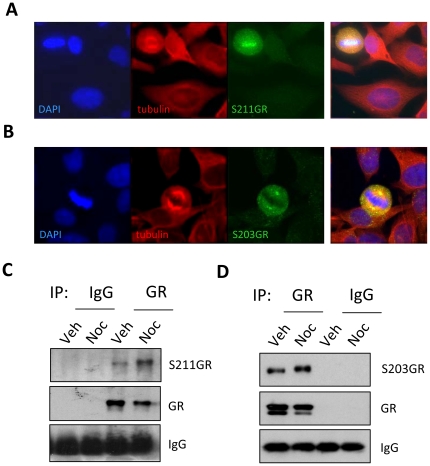
GR is phosphorylated in mitotic cells.Untreated HeLa cells cultured in CSS were double labelled with antibodies specific to tubulin and phospho-S211GR (S211GR, A) or phospho-S203GR (S203GR, B) and DNA counterstained with DAPI. Representative images of mitotic cells within a mixed population are shown. (C, D) HeLa cells were treated with vehicle (Veh) for 16 hours or synchronised with nocodazole (Noc) for 16 hours, then washed and released into mitosis. Vehicle treated cells were scraped into RIPA buffer and a pure population of mitotic cells collected from the nocodazole treated population by shake off, then pelleted and lysed in RIPA. Lysates were immunoprecipitated for GR or control IgG and precipitates electrophoresed and immunoblotted for GR together with phospho-S211GR (C) or phospho-S203GR (D). Images and immunoblots are representative of at least three independent experiments.